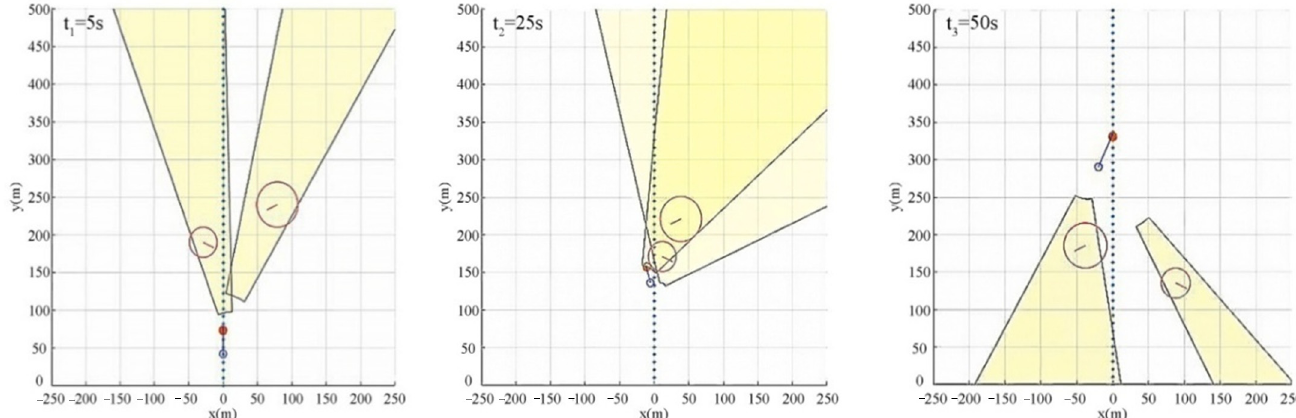
Figure 4. USV autonomous obstacle avoidance process based on the VO method in the scenario of multi-vessel encoun- ters.